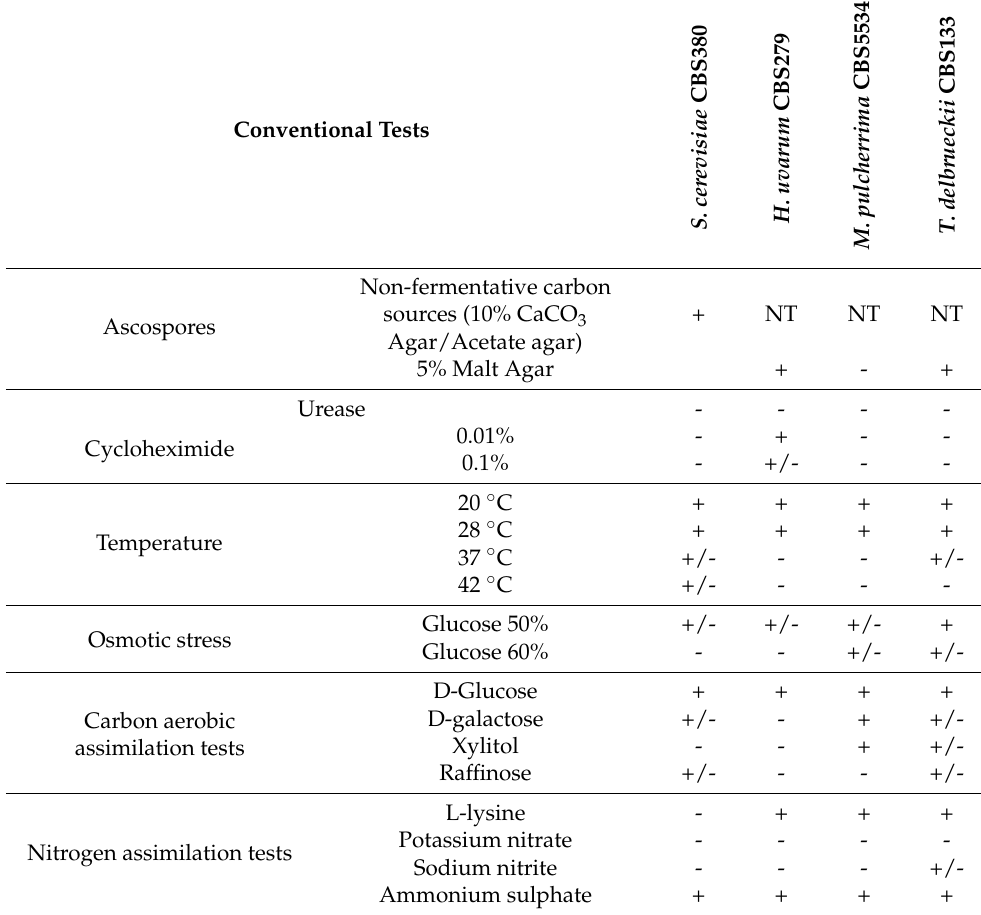
striction fragments could be observed for the isolates M1 and M5 upon using Hae III and Msp I in the restriction reaction (Figure 4—D4 and D6 and E4 and E6, respectively).